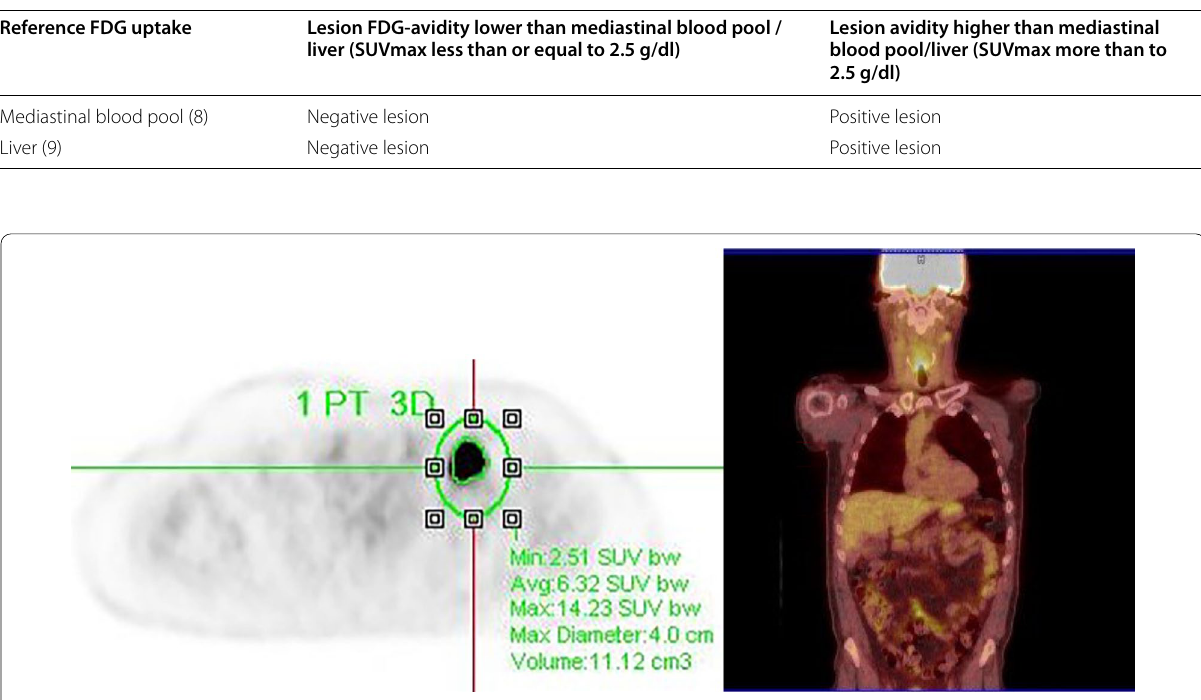
below 10.0 mmol/L for all patients prior to the time of 18 F-FDG injection. Imaging was started at 60 min after 18 F-FDG injection, covering the area from base of skull